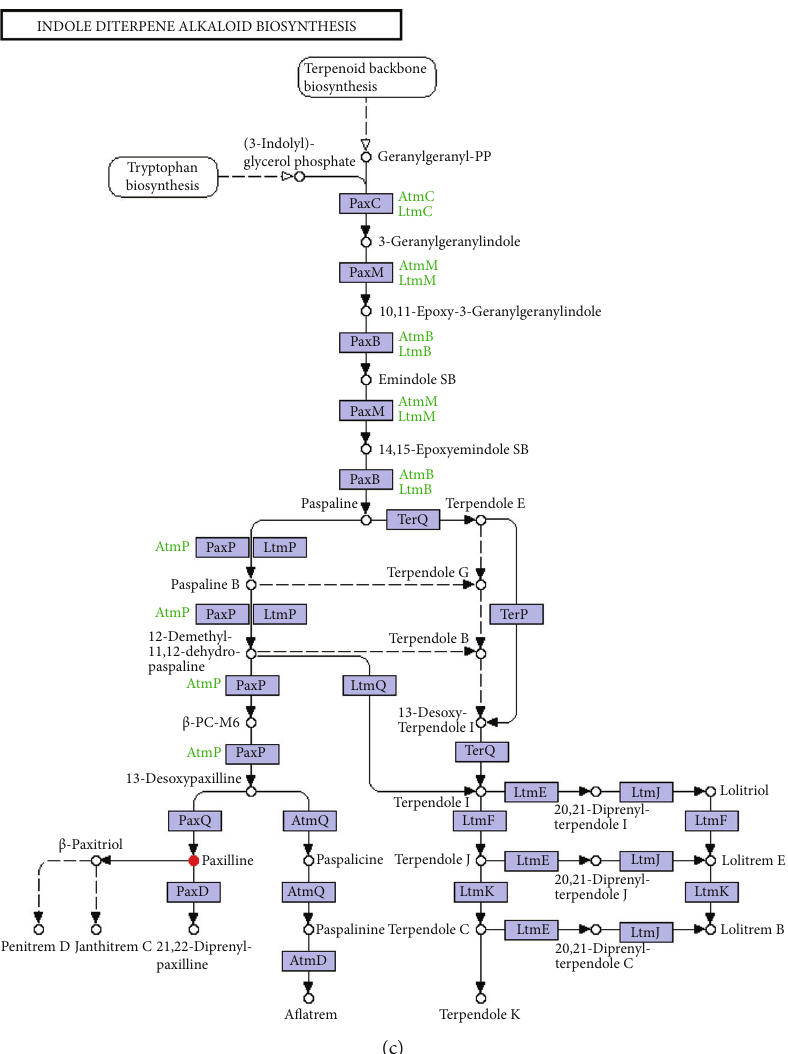
Figure 5: Metabolic pathways of Bacillus megaterium . (a) Biosynthesis of indole alkaloids. (b) Biosynthesis of tropane, pethidine, and pyridine alkaloids. (c) Indole diterpene alkaloid